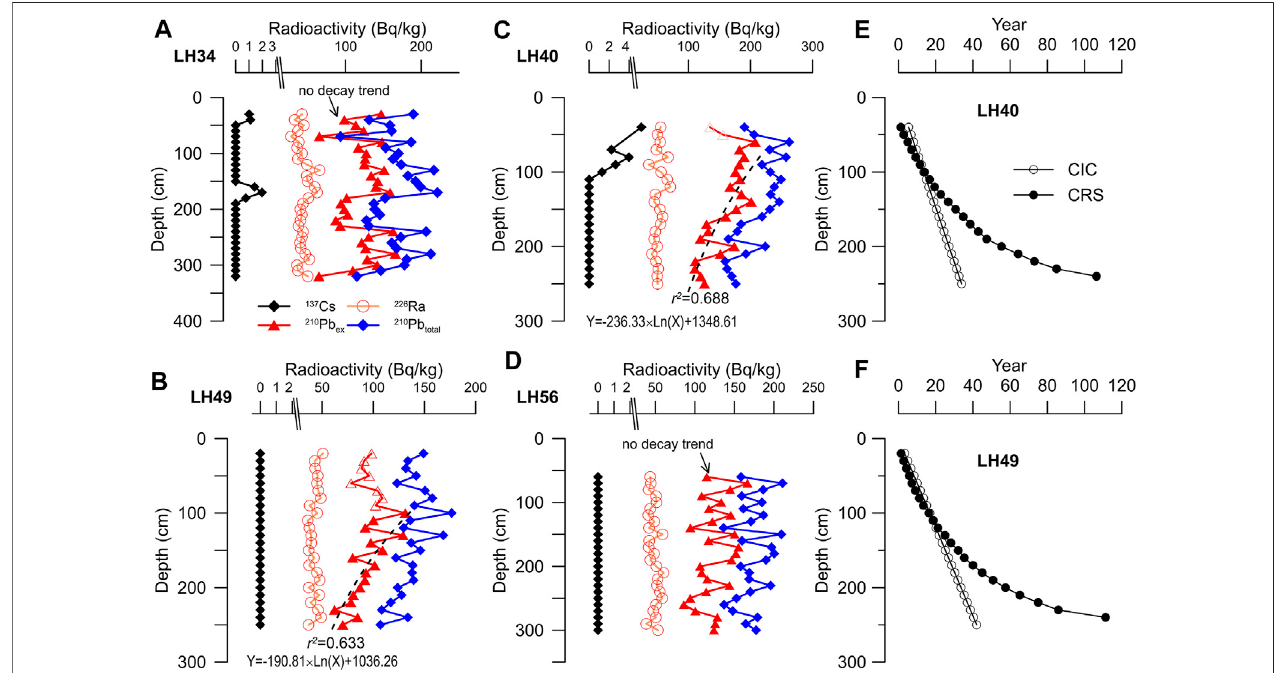
FIGURE 3 | Results of 210 Pb ex , 226 Ra, 210 Pb total, and 137 Cs activities for the four representative cores LH34, LH40, LH49, and LH56 (A – D) . Dating results of the cores LH40 and LH49 using CIC and CRS models are compared in (E) and (F) .